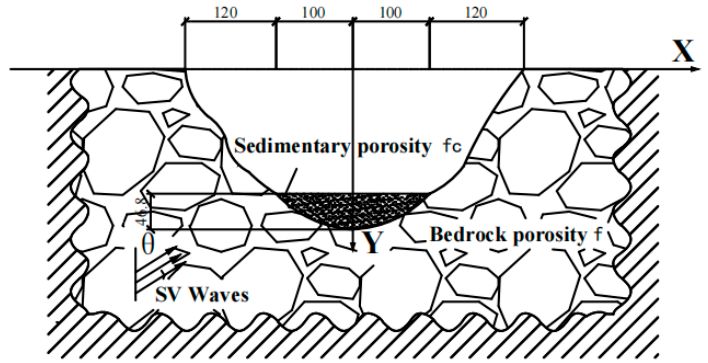
Figure 7. Random boundary sedimentary valley samples (m).